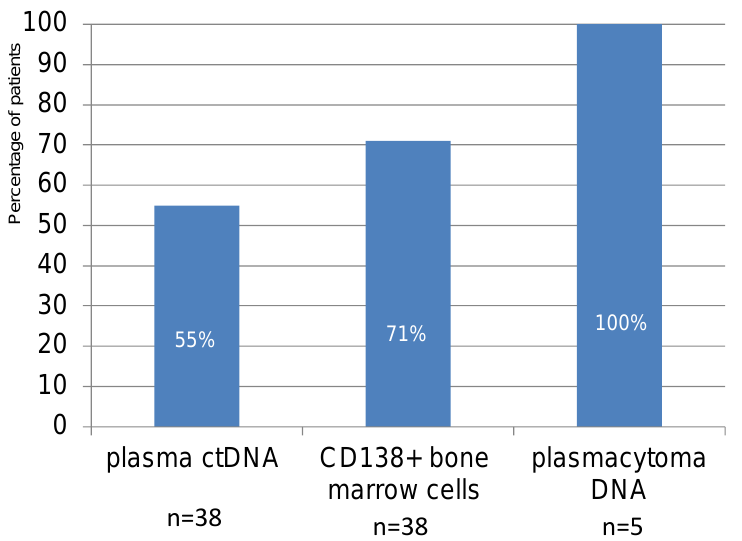
Figure 1. Frequency of aberrant STR loci occurrence in the samples from different localizations in MM patients.